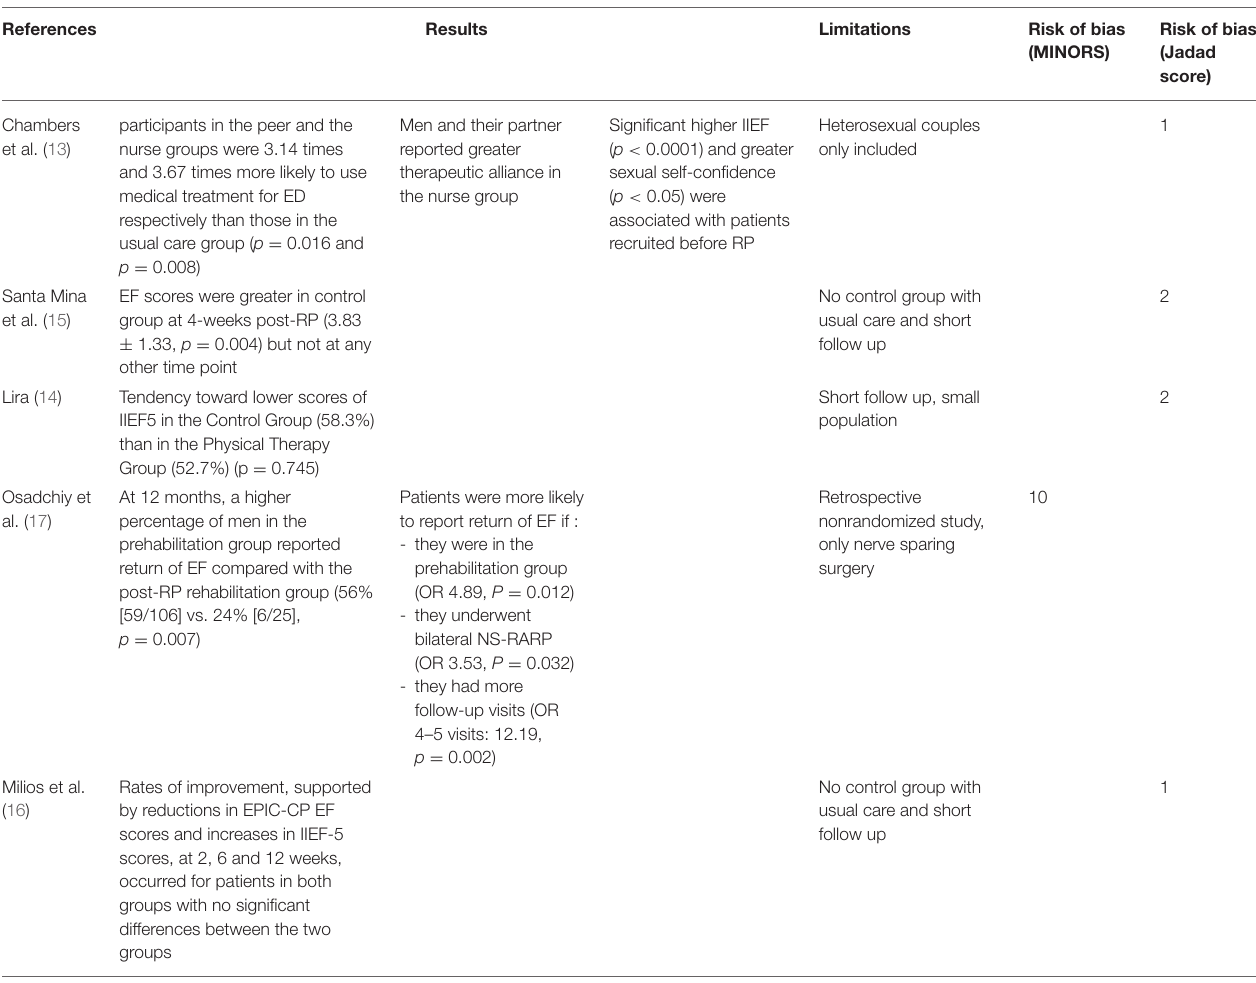
TABLE 2 | Summary of study